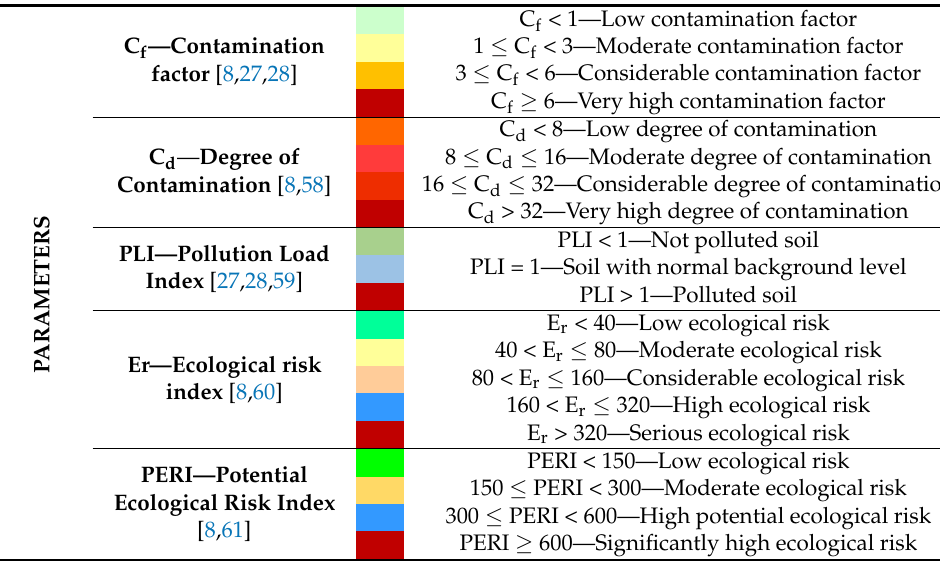
Table 1. Metal pollution indices used for soil quality